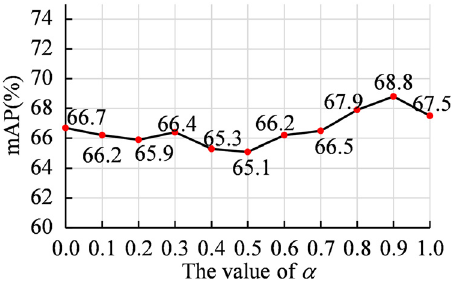
Figure 8: The impact of the balance factor on the